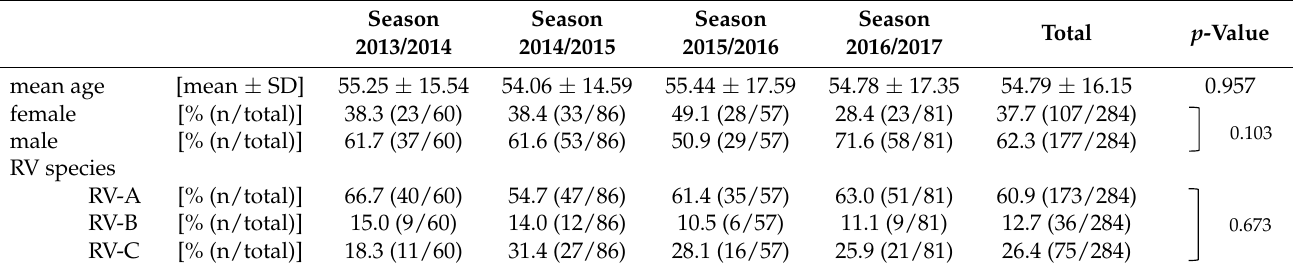
Figure 1. Monthly total numbers of tested samples and rhinovirus cases ( n = 410) stratified by species A, B, and C, as well as untypable rhinoviruses. Note the two different y ‐ axes: the left axis shows the absolute numbers of detected Rhinovirus A, Rhinovirus B, and Rhinovirus C cases, as well as the absolute numbers of untyped cases, while the right axis shows the absolute number of tested samples. Table 1. Gender, age, and rhinovirus species distribution during the study period.